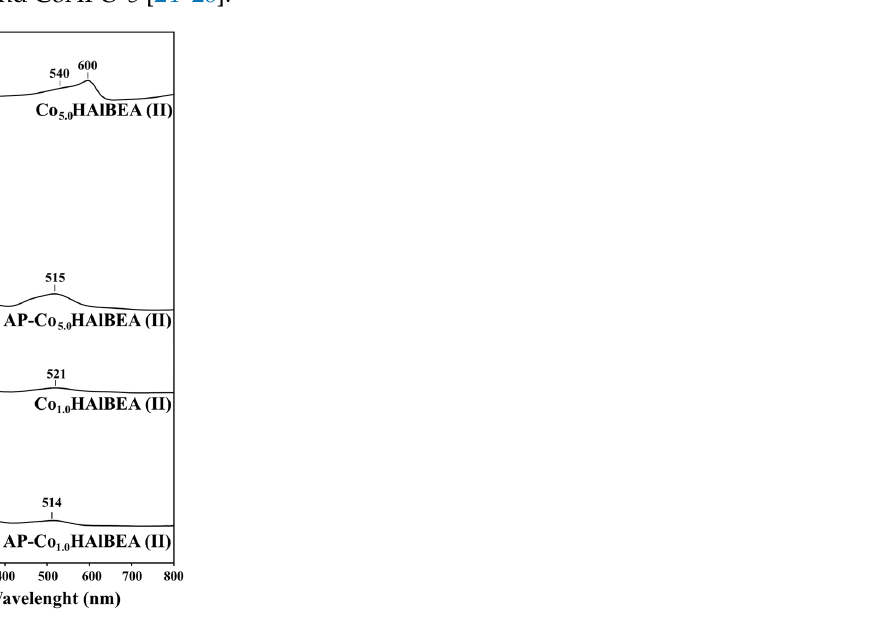
Figure 5. DR UV-vis spectra of selected samples of AP-Co x HAlBEA(II) and Co x HAlBEA(II) series recorded at room temperature and under ambient atmosphere.